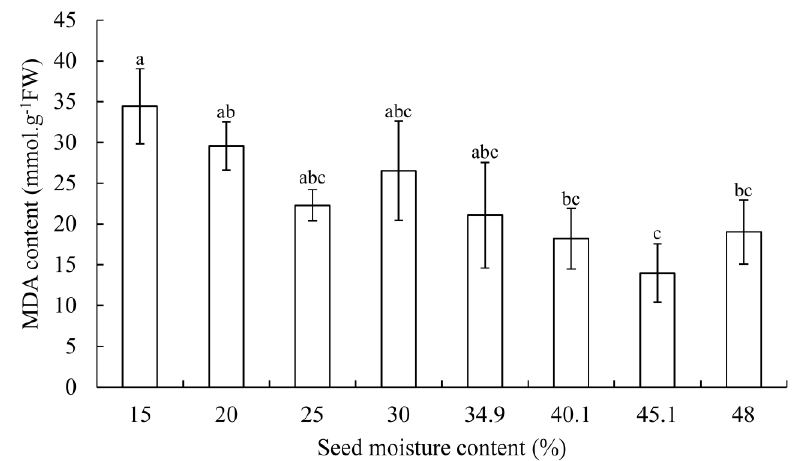
Figure 7. Changes of malondialdehyde (MDA) content in the G. biloba seed embryos during desiccation. Data are means of three replicates ± SD, and bars labeled with the same lower-case letter do not differ significantly at the 0.05 probability level.